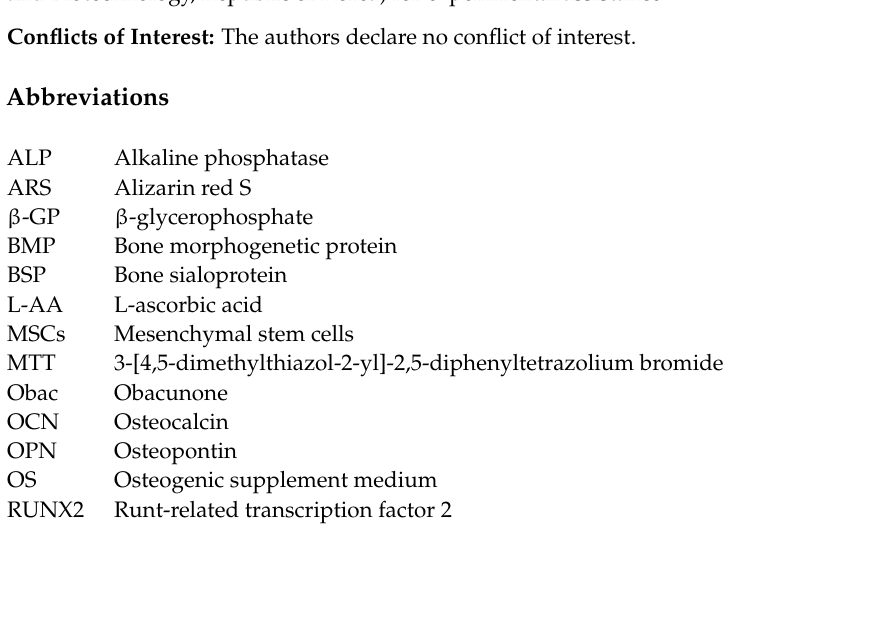
Figure S2: Magnified image of Figure 5C, Figure S3: Magnified image of Figure